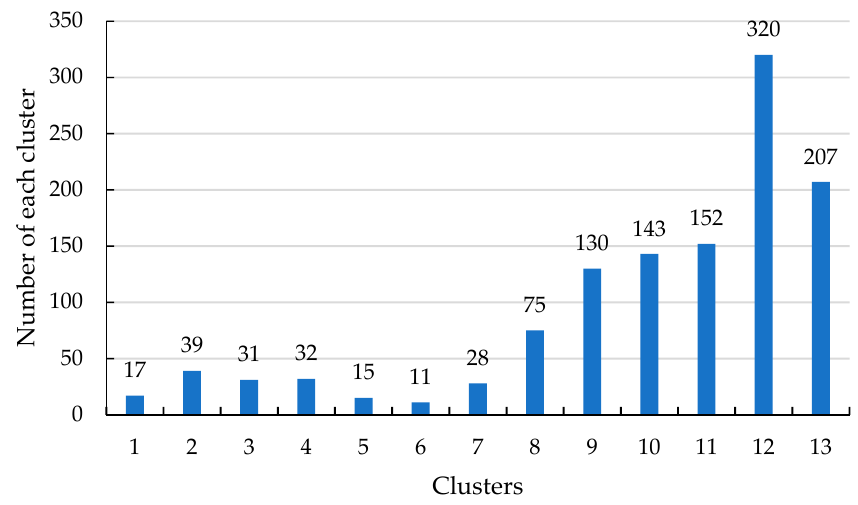
Figure 16. The number of sheath current samples in each cluster.